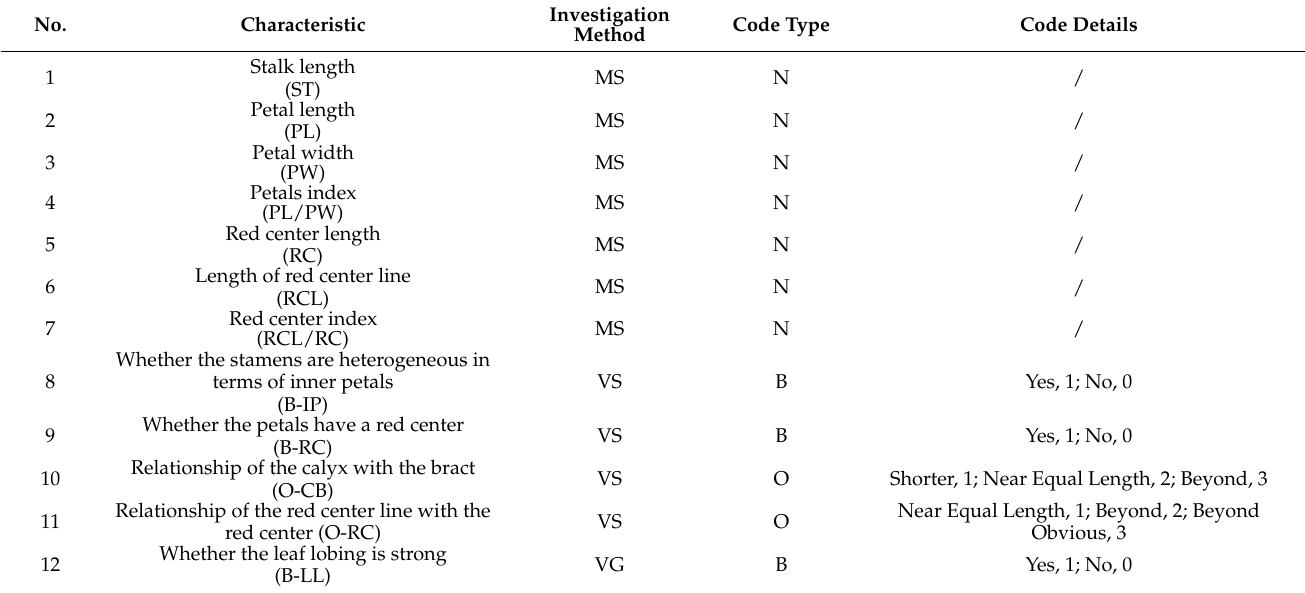
Table 3. Twelve flower and leaf traits and their codes for Hibiscus syriacus